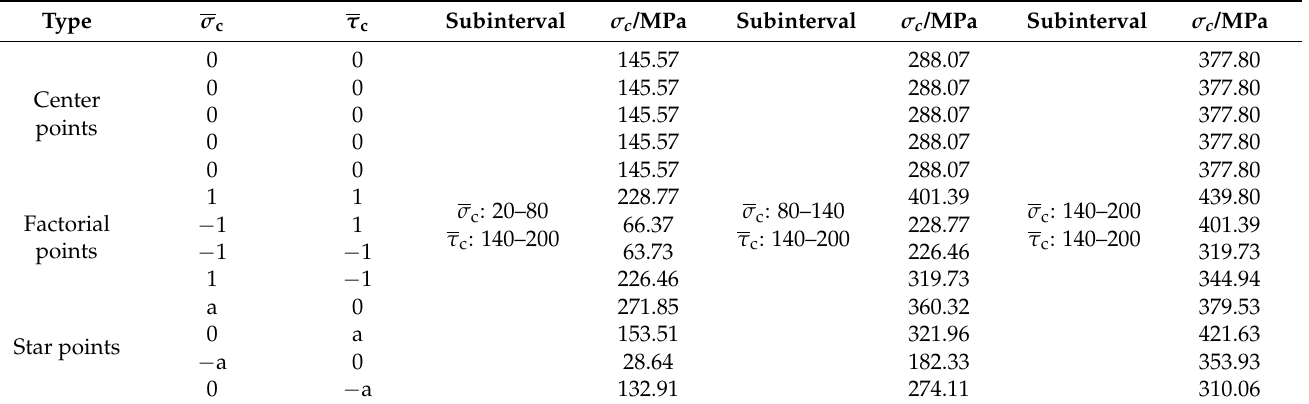
Table 7. CCD test scheme and calculation results of peak